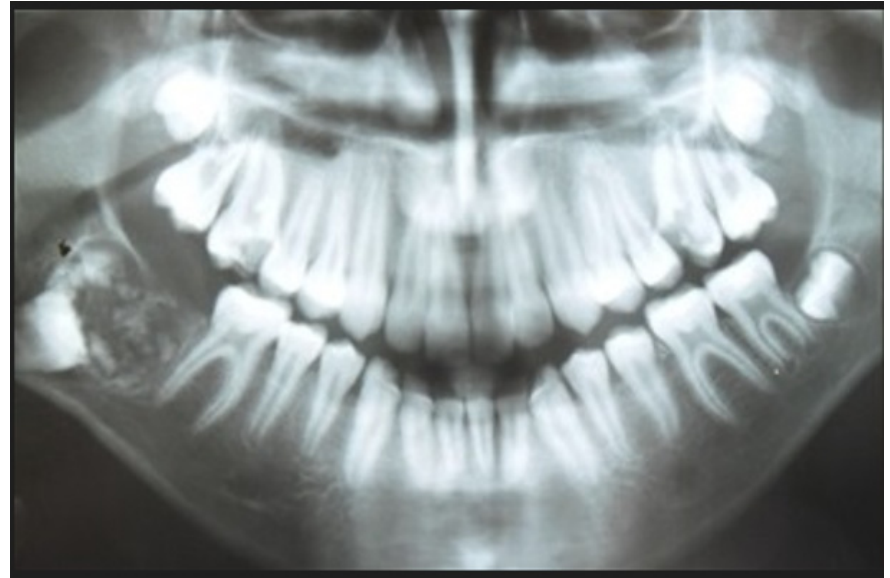
Figure 1. Preoperative panoramic radiography showed well ‐ defined radiolucent region, which contained irregular radiopaque masses of varying sizes and shapes and deeply displaced tooth 47. This lesion occupied an area from the lower right first molar area to the right ramus. Courtesy of Dr. W. Pawlak.